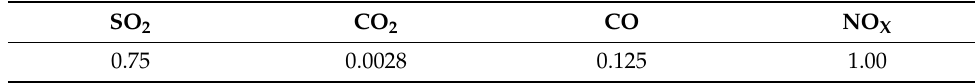
Table A2. Environmental pollutant penalty amount